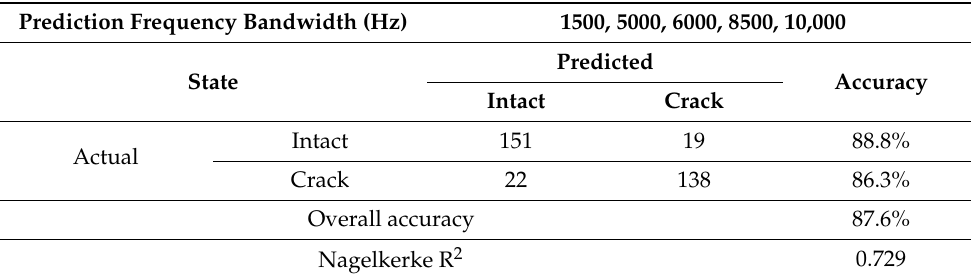
Figure 5. Model 5 ROC curve for the validation group. Table 4. Model 5 confusion matrix for the validation